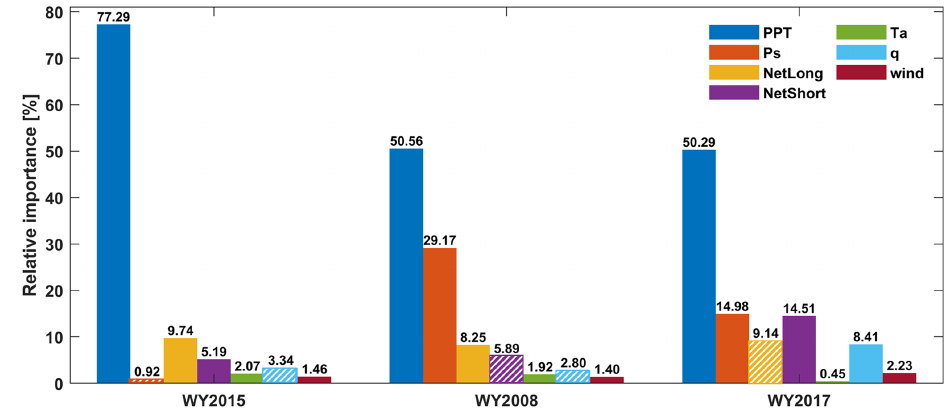
Figure 8. Relative importance (%; normalized values of absolute change of MAE after removing one forcing field) of each meteorological forcing in DNN-based full-domain SWE estimates in WY2015, WY2008 and WY2017. The bars with dashed lines indicate that removing those variables decreases the value of MAE, while solid bars indicate that removing those variables increases MAE.